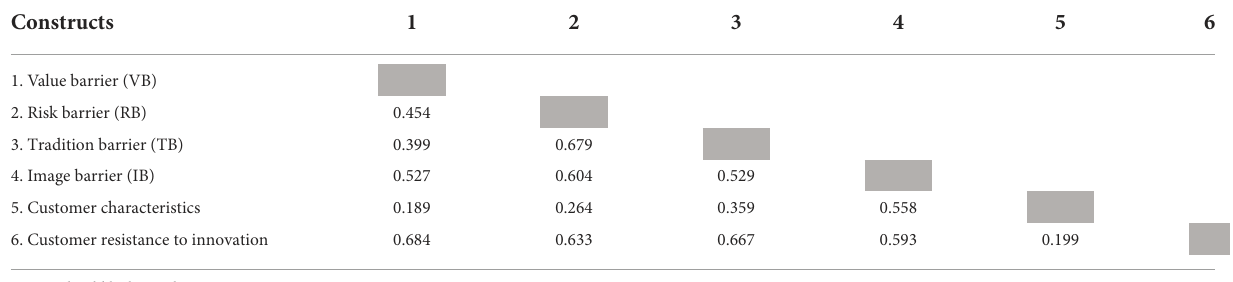
TABLE 5 Structural path analysis: direct effect.